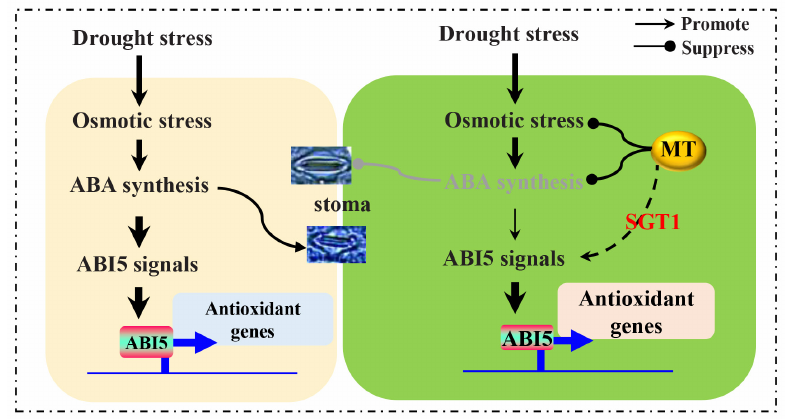
Figure 8. Models explaining the ameliorated effects of melatonin on seedling growth via SGT1- involved signals under drought stress in rice ( Oryza sativa